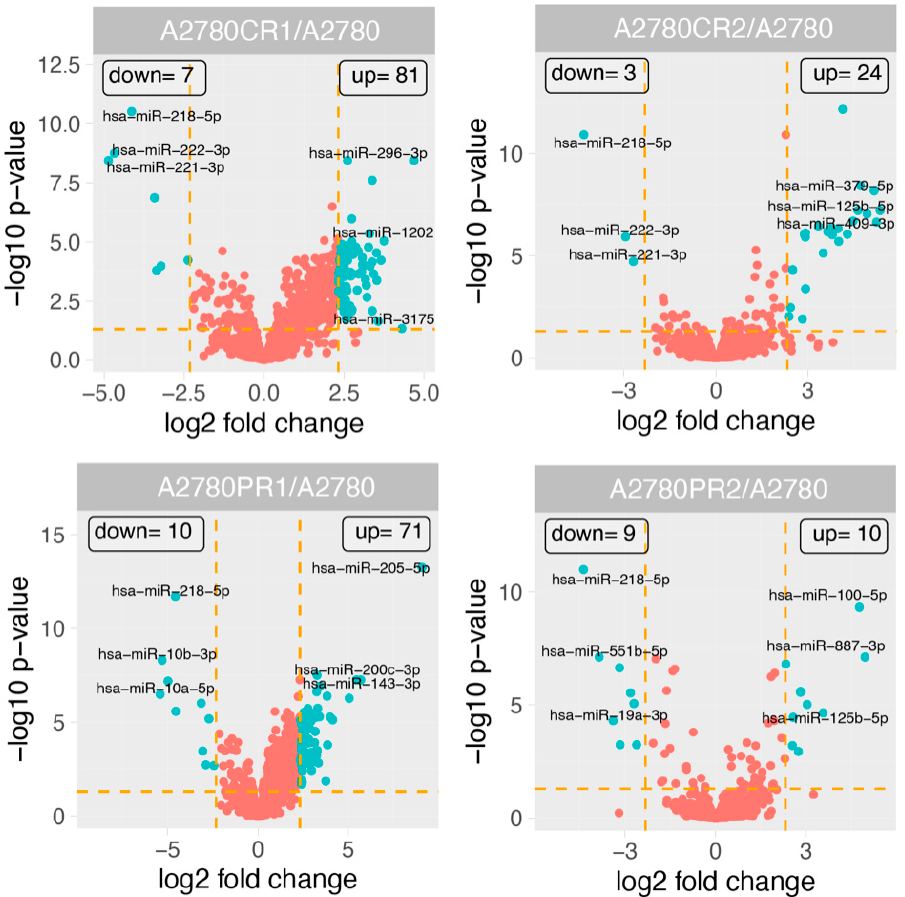
Figure 1. Volcano plots displaying the miRNA with expression levels that were upregulated or downregulated (green dots) by 5-fold or more in drug-resistant cells in relation to the A2780 cells. Red dots indicate miRNAs below cut-off criteria (|fold| > 5, p < 0.05). The expression of three miRNAs was changed in all investigated cell lines, and among them, expression of miR-218-5p was downregulated in all investigated cell lines. Expres- sion of miR-221-3p and miR-222-3p was downregulated in both CIS-resistant cell lines but upregulated in both PAC-resistant cell lines. Expression of five miRNAs was changed in three of four cell lines, and among them expression of miR-125b-5p, miR-887-3p was upregulated in both CIS-resistant cell lines and in the A2780PR2 cell line, expression of miR-296-3p was upregulated in both CIS-resistant cell lines and in the A2780PR1 cell line, expression of miR-99a-5p was upregulated in both CIS-resistant cell lines but downregu- lated in the A2780PR2 cell line, and expression of miR-551b-3p was downregulated in both PAC-resistant cell lines and the A2780CR1 cell line. Additionally, miR-551b-5p was down- regulated in both PAC-resistant cell lines and expression of miR-4485 was upregulated in both PAC-resistant cell lines Thus, the upregulation of miR-125b-5p, miR-99a-5p, miR- 296-3p, miR-887-3p, and miR-4485, and downregulation of miR-218-5p, miR-221-3p, and miR-222-3p, was specific to CIS-resistance. On the other hand, upregulation of miR-221-3p and miR-222-3p, and downregulation of miR-551b-3p, miR-551b-5p, and miR-218-5p, was specific for